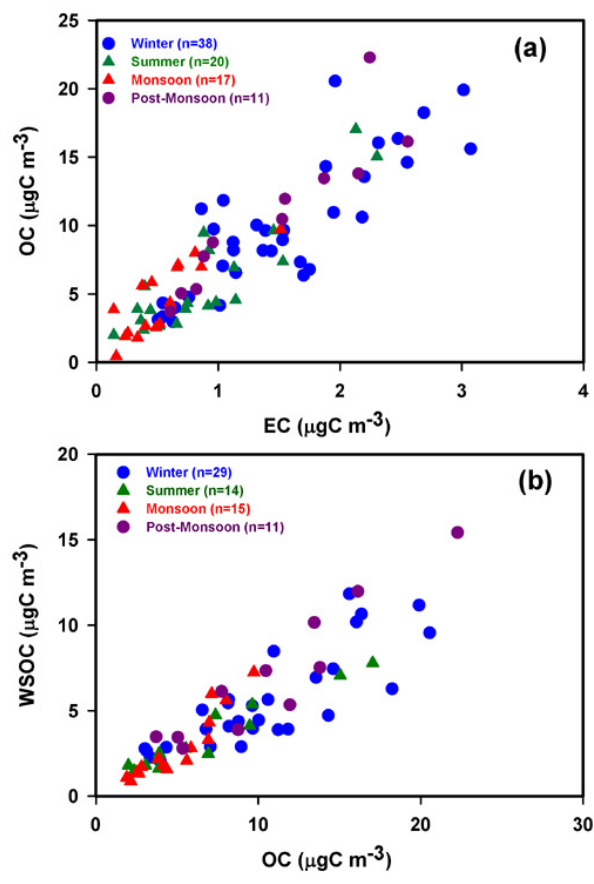
Fig. 5. Scatter plots between (a) OC and EC and (b) WSOC and